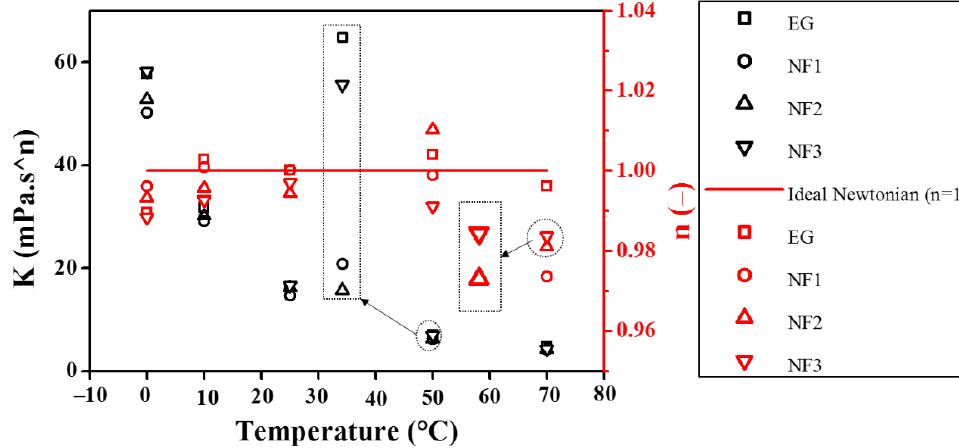
Figure 4. Consistency index ( K ) and flow index (n) obtained from Herschel–Bulkley model fitting.